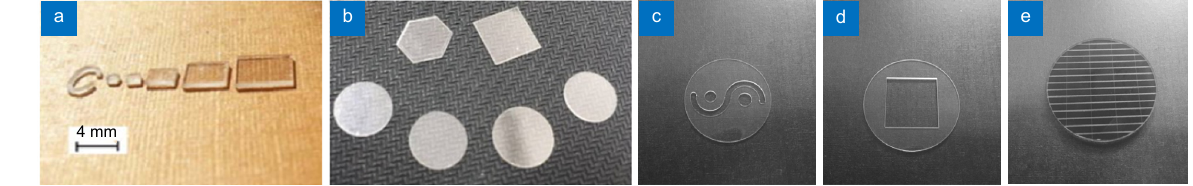
Fig. 14 | ( a , b ) Shaped cutting parts of sapphire cutting samples. ( c ) Tempered glass. ( d ) Quartz glass. ( e ) Solar glass. Figure reproduced with permission from: (a,b) ref. 77,78 . (c–e) ref. 79 , Applied Laser.